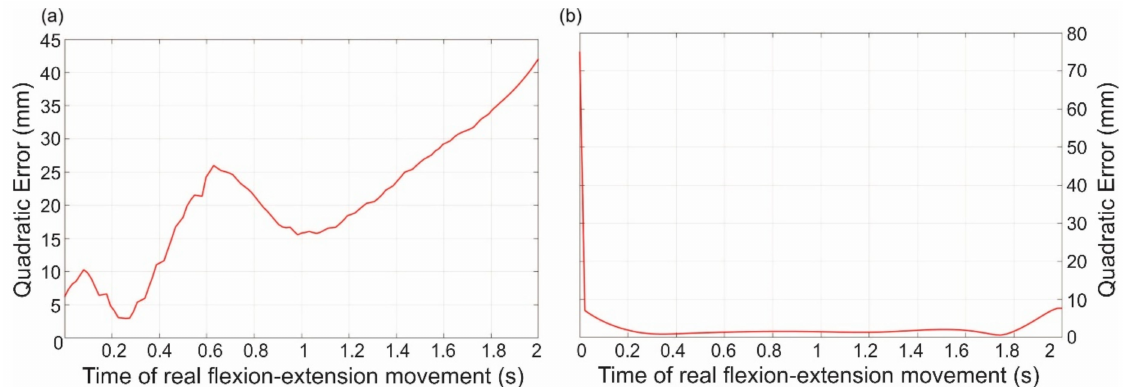
Figure 20. The error between trajectories: ( a ) with the original mechanism, ( b ) with the optimized mechanism. To validate the quality of the convergence, Figure 21 shows the histogram of the last population. The histogram shows the distribution of the last population in the upper and lower limits of each individual. The frequency represents the number of times that an indi- vidual is presented in each limit. The cumulative frequency (expressed in percentage) is the sum of the absolute frequencies and indicates the number of individuals in each interval.